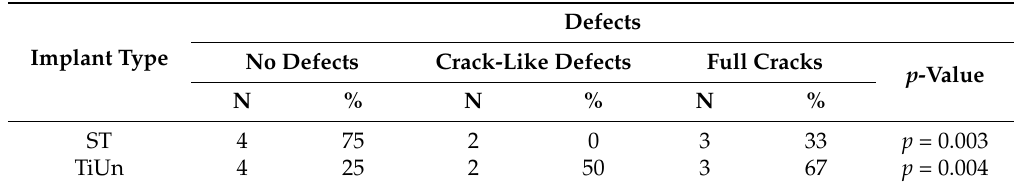
Figure 4. ( A ) Representative micro ‐ Raman spectra recorded on the surface of received implants at a laser power of 5 mW showing marked differences within the intensities attributed to symmetric stretching vibration of PO 3 − (inorganic phosphate); ( B ) Representative micro ‐ Raman spectra recorded 4 on the surface of the implants showing the main peak centered at 2940 cm − 1 related to CH bonds.